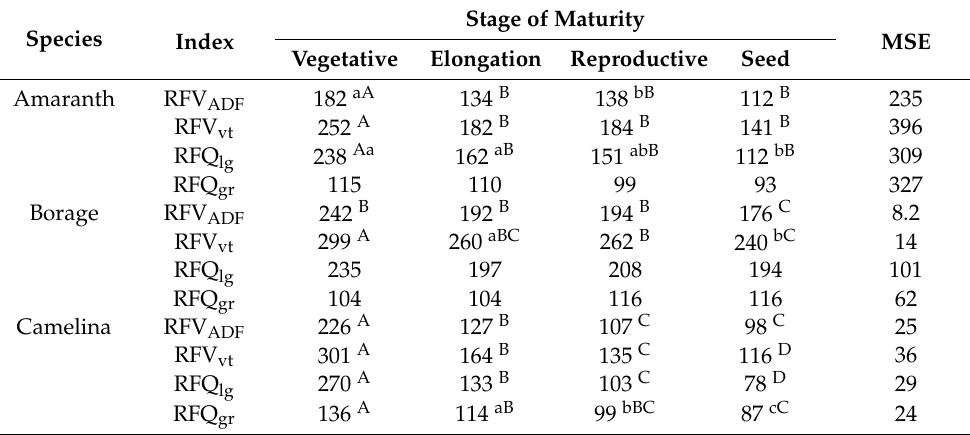
Table 5. Lsmean and mean square of error (MSE) of the calculated indexes at the vegetative, elongation, reproductive, and seed stages (g kg − 1 DM; Amaranth DFE = 10; Borage DFE = 6; Camelina DFE = 11), when using the formulae for legumes ( lg ) and grasses ( gr ). Stage of Maturity Species Index MSE Vegetative Elongation Reproductive Seed